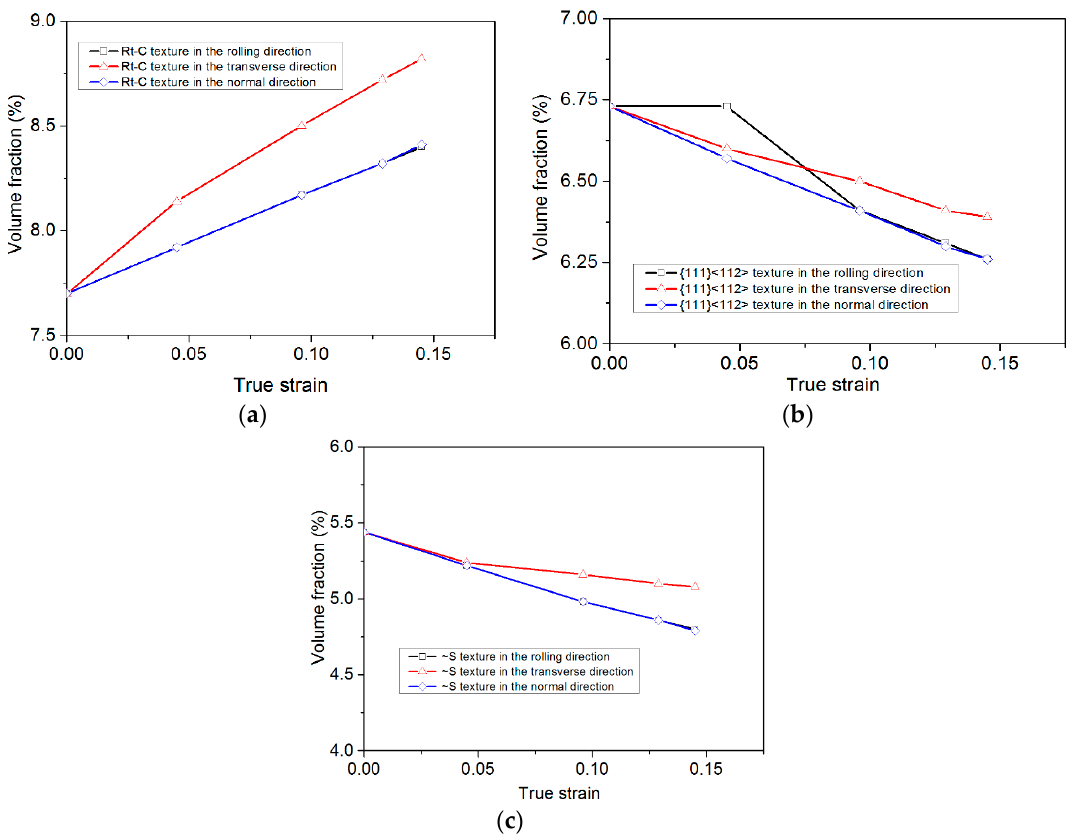
Figure 11. The volume fraction evolution of several textures in different stretching directions. ( a ) Rt-C texture; ( b ) {111} <112> texture; ( c ) ~S texture. Table 6. Miller indices and Euler angles for common texture components in cubic ‐ crystal metals.